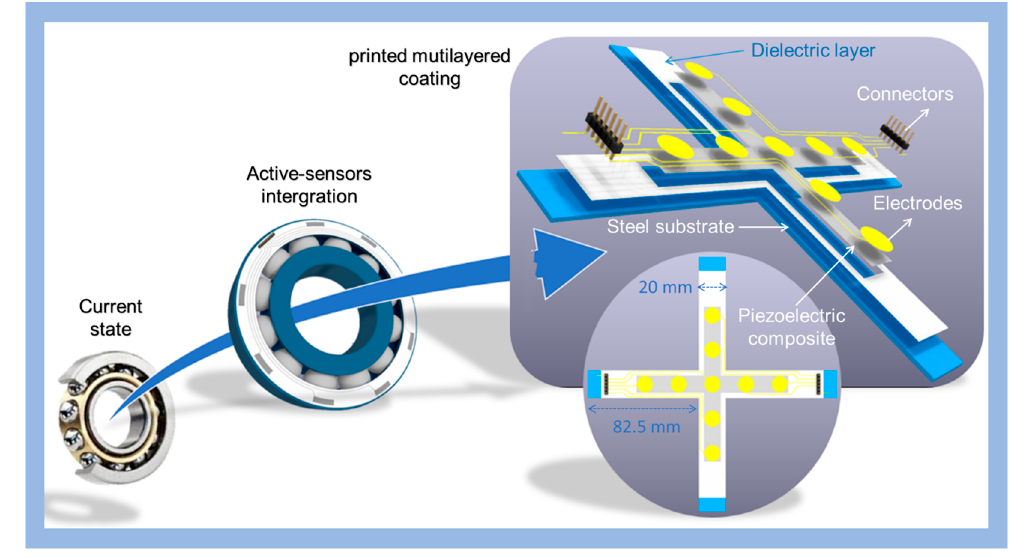
Figure 1. From the current state of bearings to a new generation coated with bidirectional printed sensor for condition monitoring.